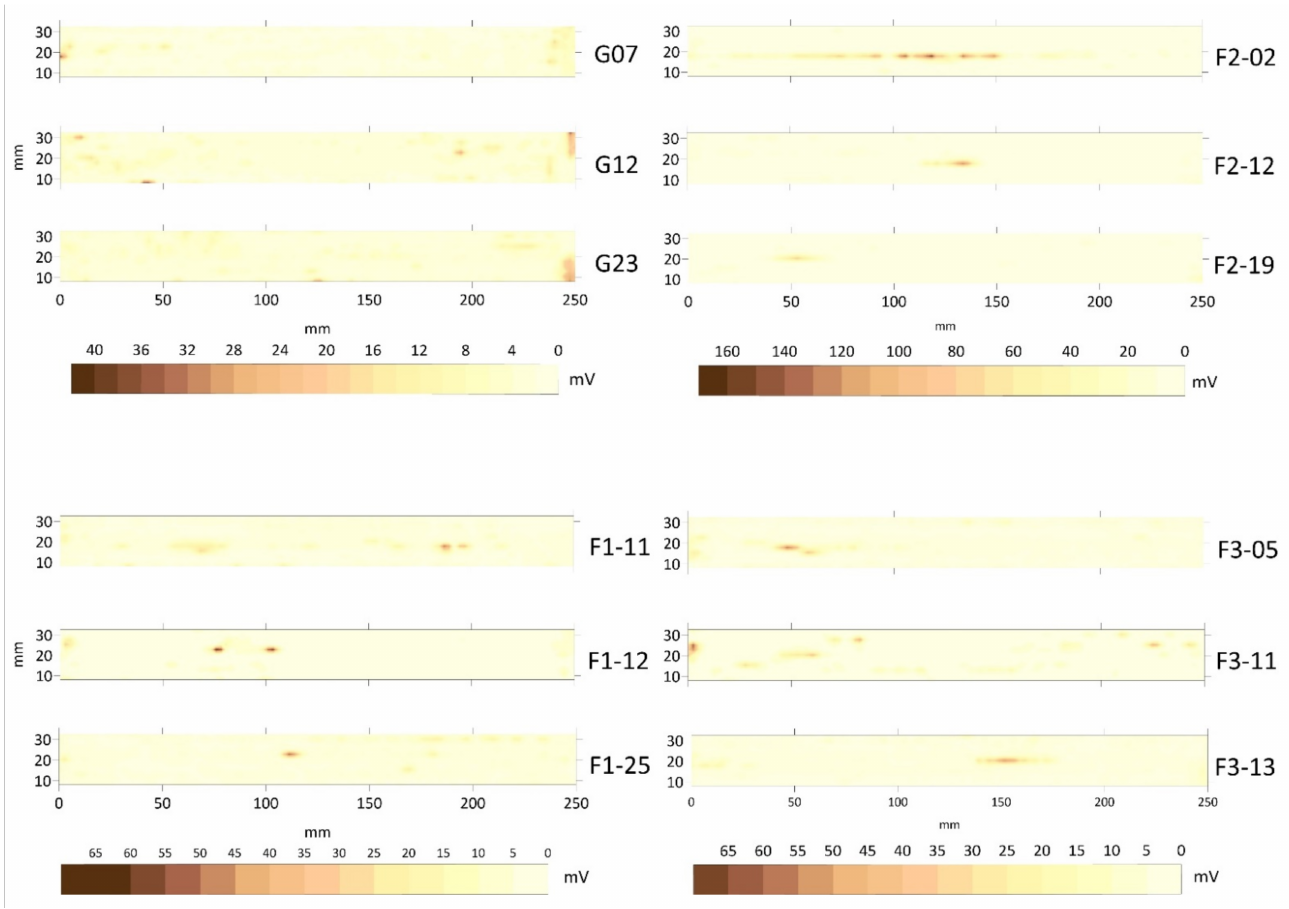
Figure 3. Top view for three cases of probes (G) and the cases of pores (F1), slag intrusion (F2) and cracks (F3). The x –axis is the distance from the left side and along the joint in millimeters and the y –axis is the transversal distance from the lower limit of the plate. Distances are in millimeters and echoes in